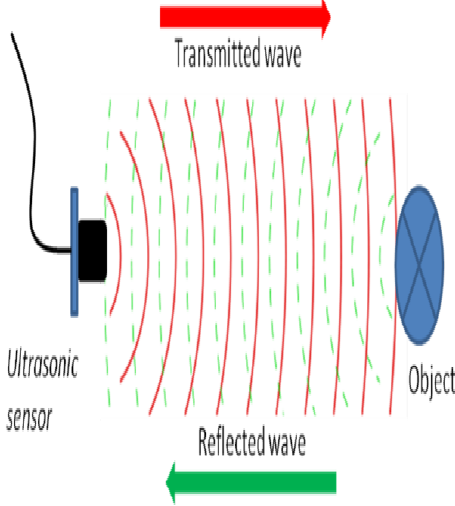
Figure 1: Principle of active